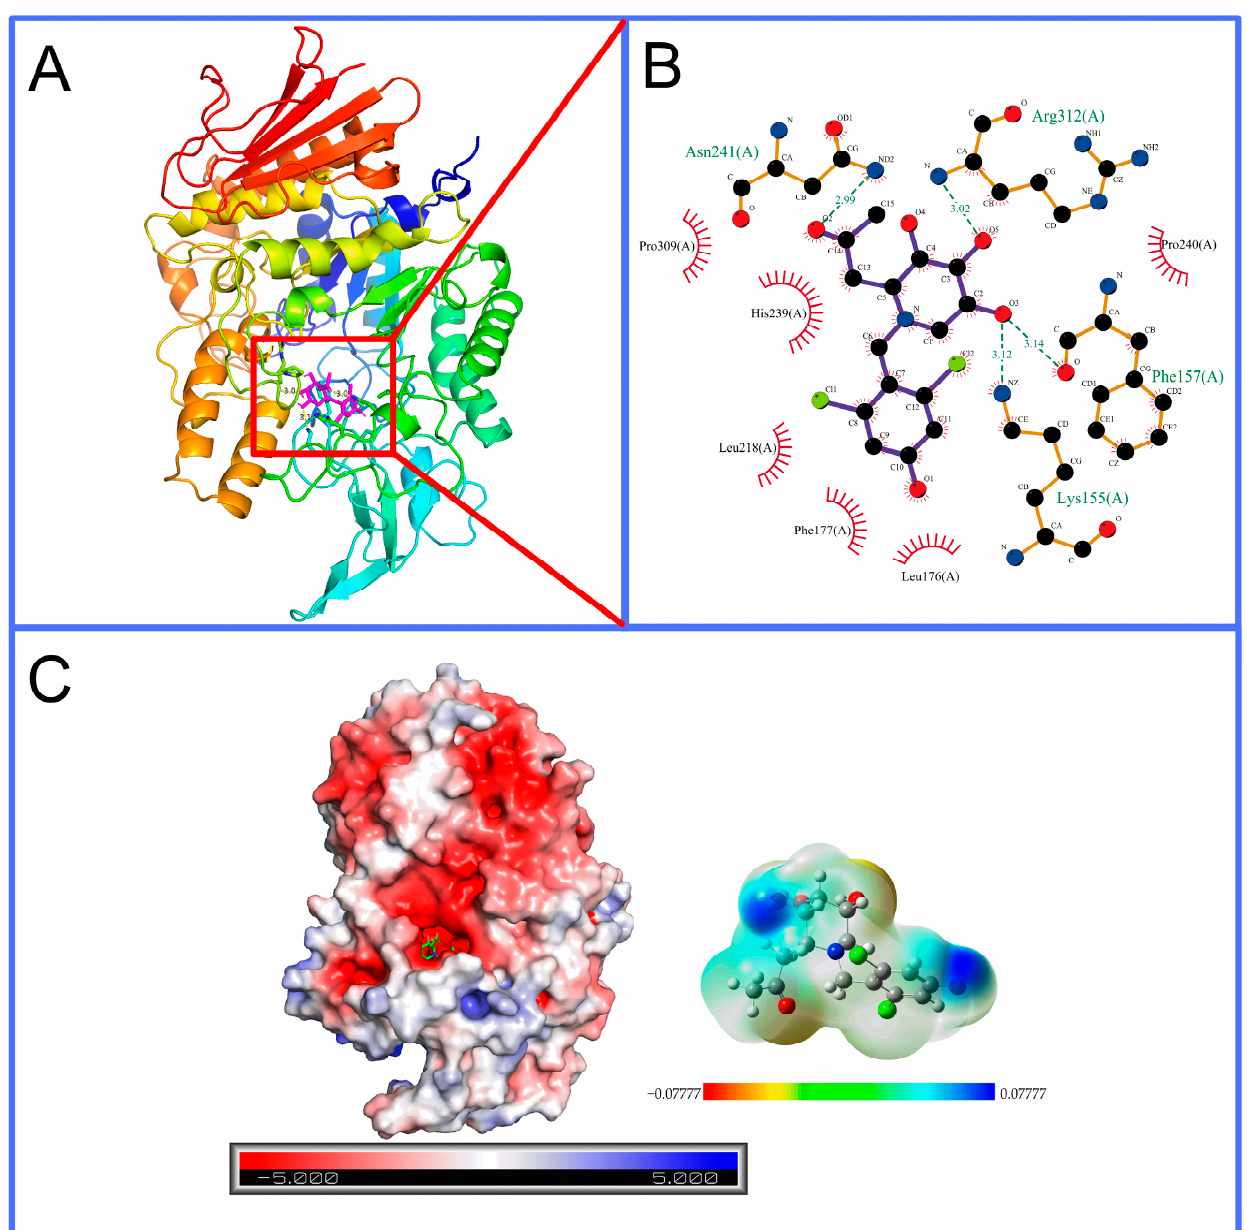
Figure 6. Binding interactions results of molecular docking between compound 6e and α -glucosidase. ( A ) The ligand and protein are shown as magenta-colored stick models and colored cartoons, respectively. ( B ) Interactions between compound 6e and its surrounding amino acid residues. ( C ) The electrostatic potential (ESP) map of α‐ glucosidase and compound 6e . The scale of the ESP of α‐ glucosidase is − 5.000 (negative, red) to 5.000 (positive, blue). The isovalue of 0.0004 electron/bohr 3 was selected for the definition of the density surface of 6e with a scale of − 0.07777 (red) to 0.07777 hartree (blue).